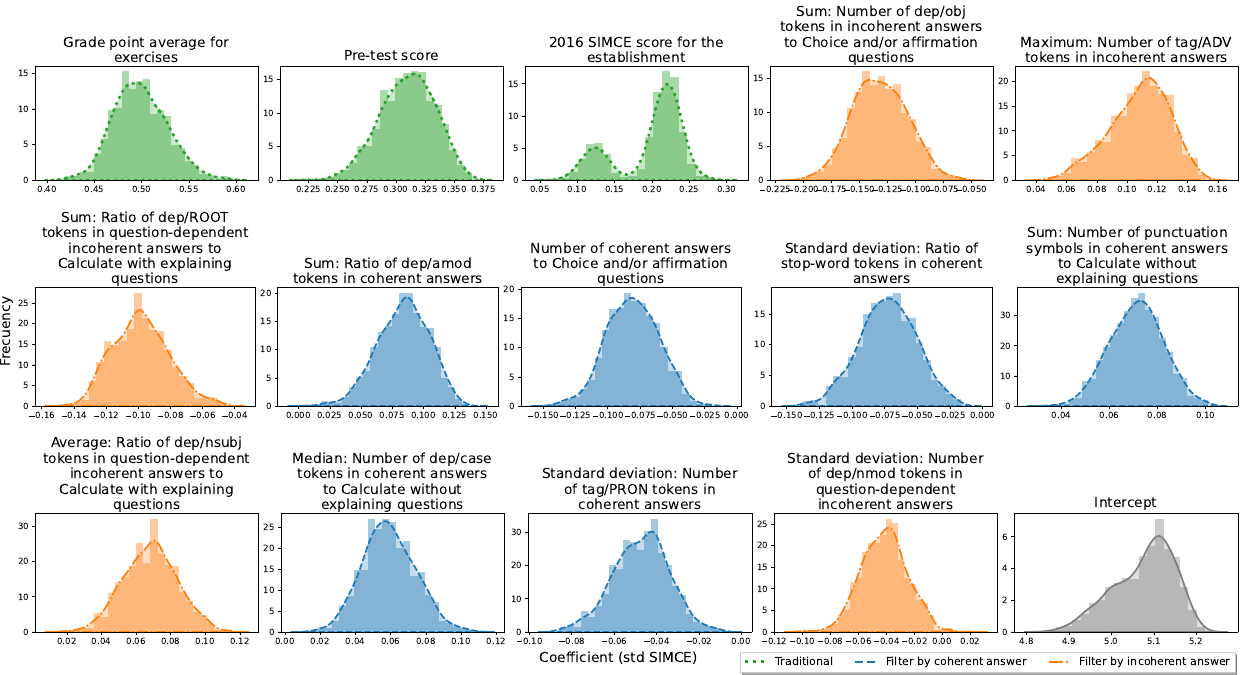
Figure 2. Distribution of each coefficient (std SIMCE) for the baseline model. These are obtained from 250 four-fold cross-validations. (Green) Traditional regressors.